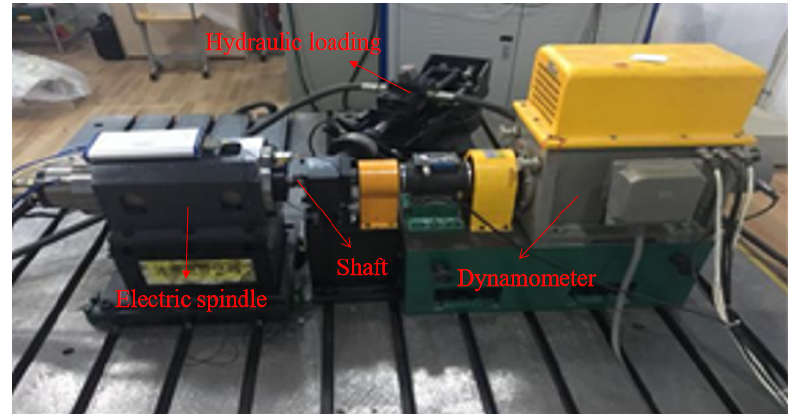
Figure 10. The main part of the bearing vibration and impact fatigue testing machine.